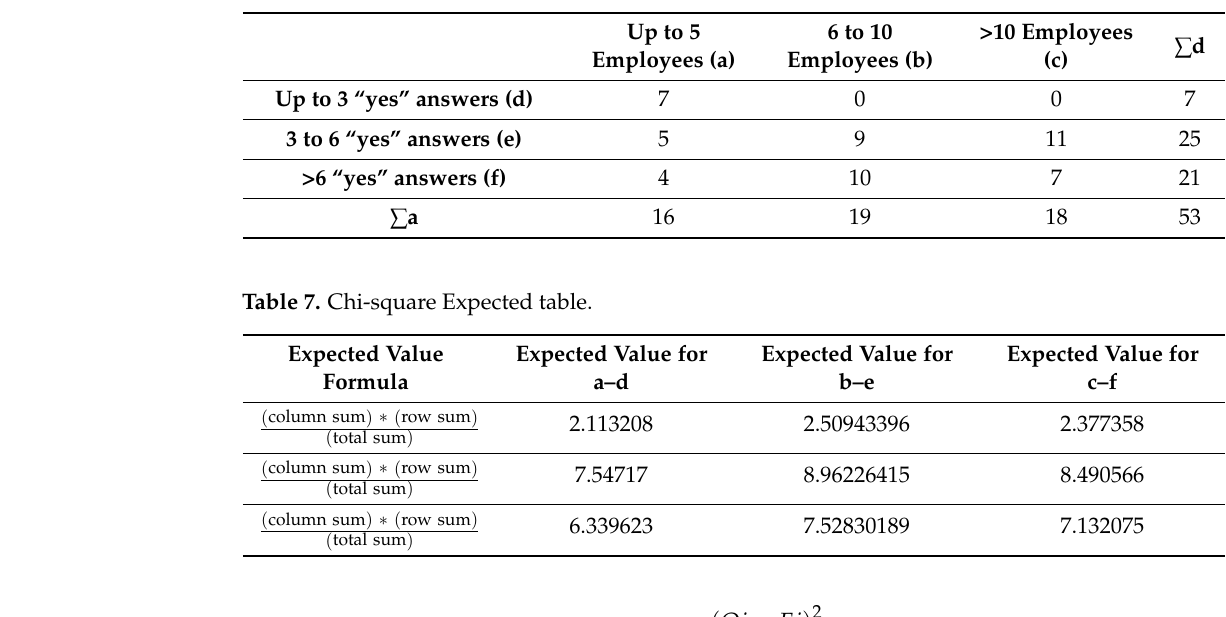
Table 6. Chi-square Empirical Table.